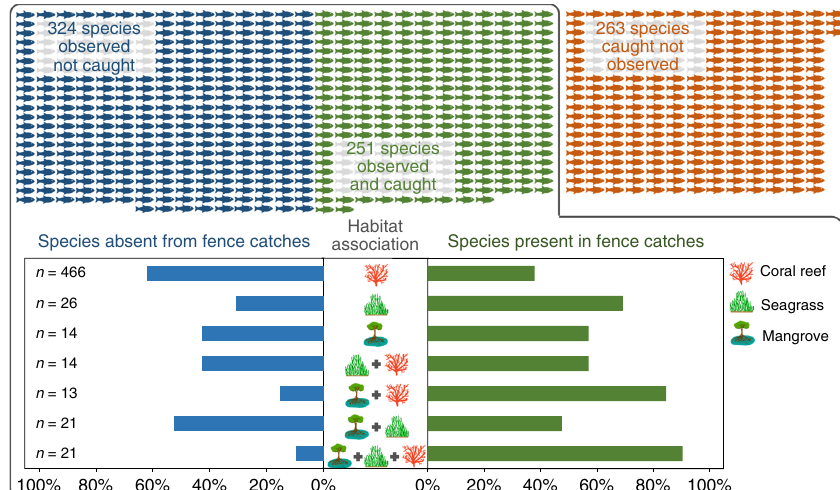
Fig. 4 Visual representation of the 838 fi sh species recorded locally, separated by their presence in visual surveys only (blue fi sh), fi sh fence catch monitoring only (red fi sh) or both (green fi sh). All 575 species recorded in visual surveys (inside 'box) were then allocated habitat associations, based on which visual surveys they were recorded in (coral reef, seagrass, mangrove). For each habitat association, the proportion (%) of species present in (blue bars) and absent from (green bars) fi sh fence catches are shown, with the total number of species allocated to that habitat association ( n ). Symbol artwork produced by Olivia Farman, Operation